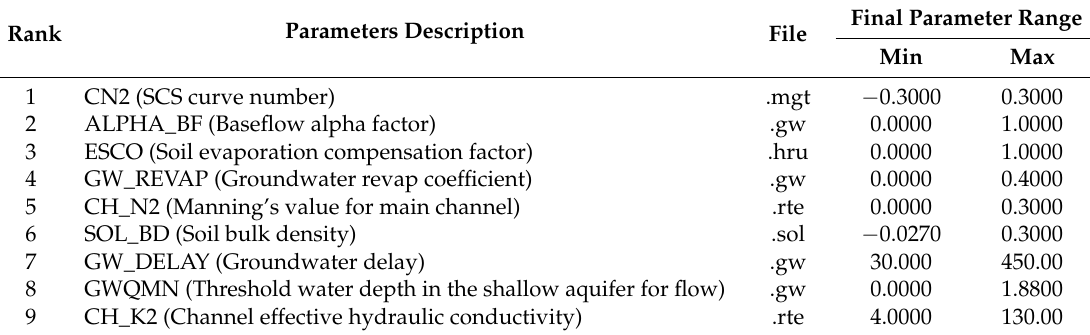
Table 5. SWAT parameter changes during calibration